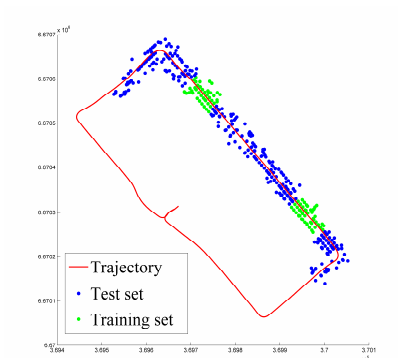
Figure 2. Trajectory of the scanner of the EuroSDR test site (red), and poles and tree trunks of the independent test set (blue dots) and training set (green dots) of the test area B.